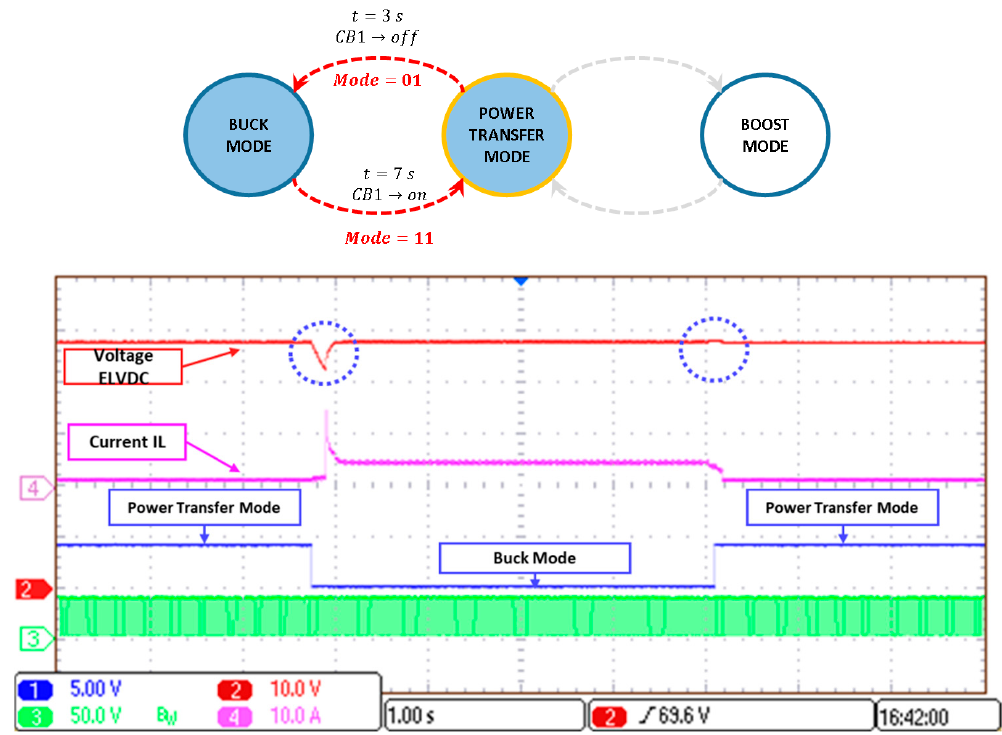
Figure 23. Experimental waveforms to transition between power transfer and buck modes.